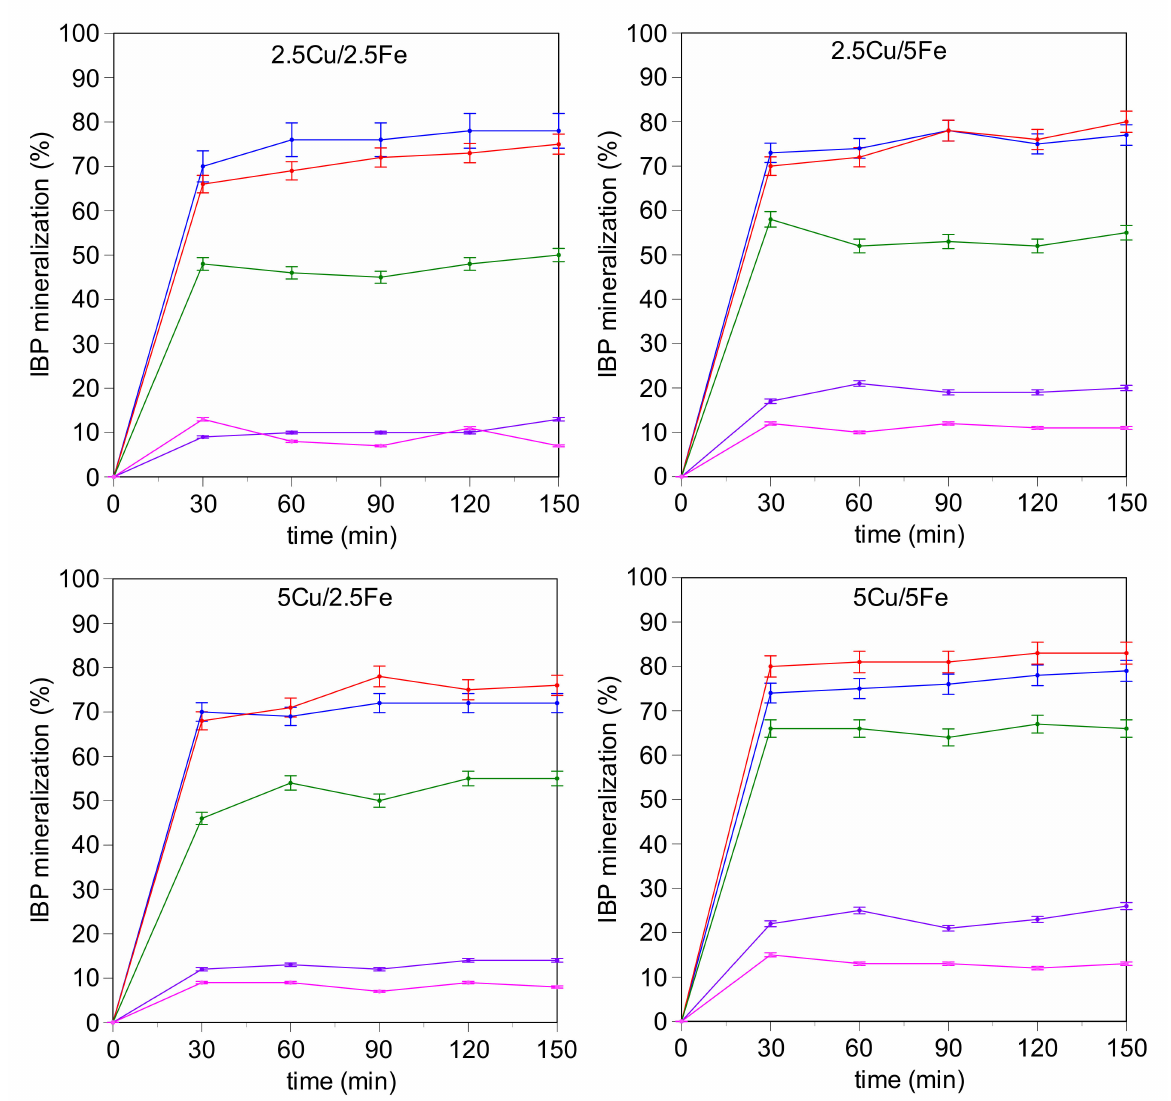
Figure 4. Effect of pH on the IBP mineralization by bimetallic catalysts: pH 3 blue, pH 4 red, pH 5 green, pH 6 purple, pH 8 pink. (Reaction condition: catalyst dose—200 mg/L, H 2 O 2 dose—30 mL/L, temperature —70 ◦